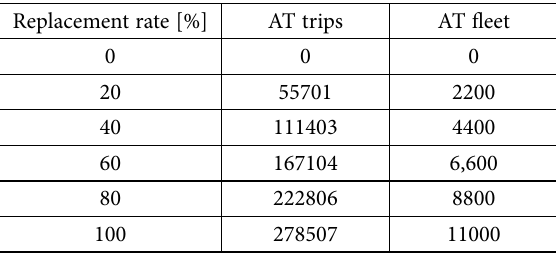
Table 1. Replacement rate of car trips by AT mode and corresponding fleet